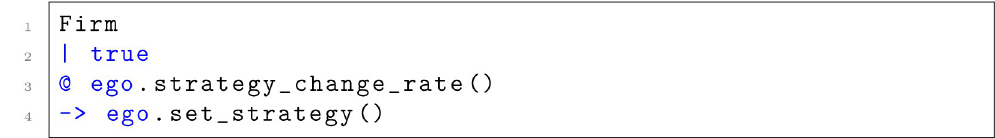
Fig 4. Update rule of firms for prices and production quantity in ML3. Note: The Figure shows the supply mechanism rule, modeling firm production behavior as shown in Eq 1 at the transition rate defined in Eq